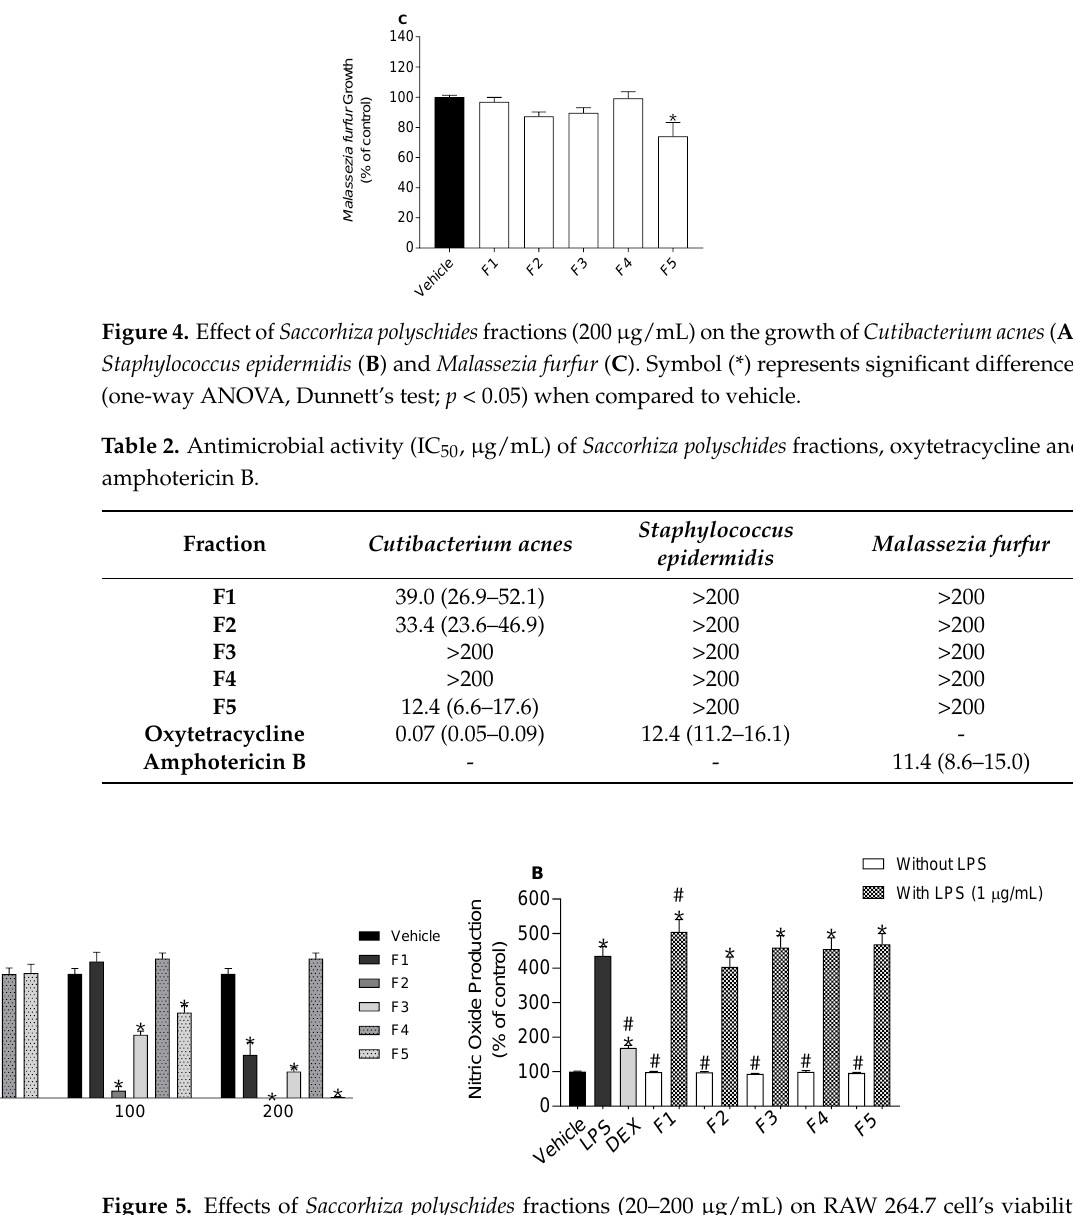
Figure 5. Effects of Saccorhiza polyschides fractions (20–200 µ g/mL) on RAW 264.7 cell’s viability following treatment for 24 h. ( A ) Nitric oxide (NO) levels (% of control) following exposure with Saccorhiza polyschides fractions (20 µ g/mL), LPS (1 µ g/mL), dexamethasone (DEX) (20 µ g/mL) and LPS in the presence of Saccorhiza polyschides fractions (20 µ g/mL) ( B ). Symbols represent significant differences (one-way ANOVA, Dunnett’s test; p < 0.05) when compared to vehicle (*) and LPS (#).